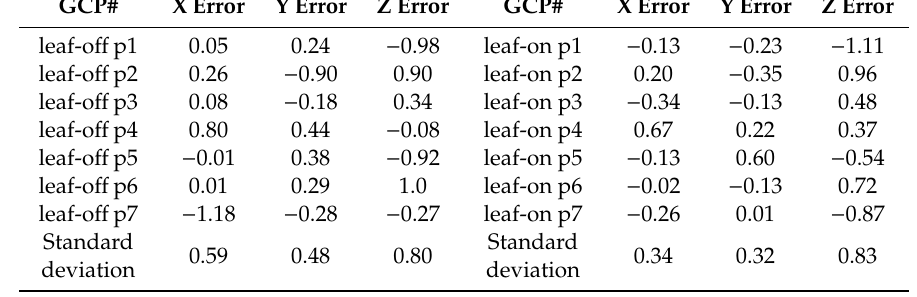
Table 2. Accuracy of the GCP in the stereoscopic processing of UAV stereo imagery (in meter).